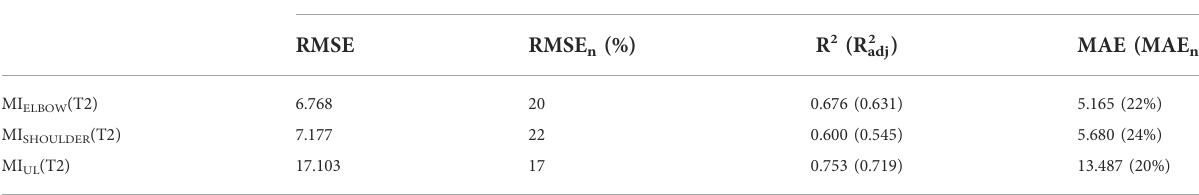
TABLE 3 Results from the predictive models for the discharge clinical outcomes (MI ELBOW , MI SHOULDER , MI UL )by applying the Leave-One-Out Cross- Validation (LOOCV)